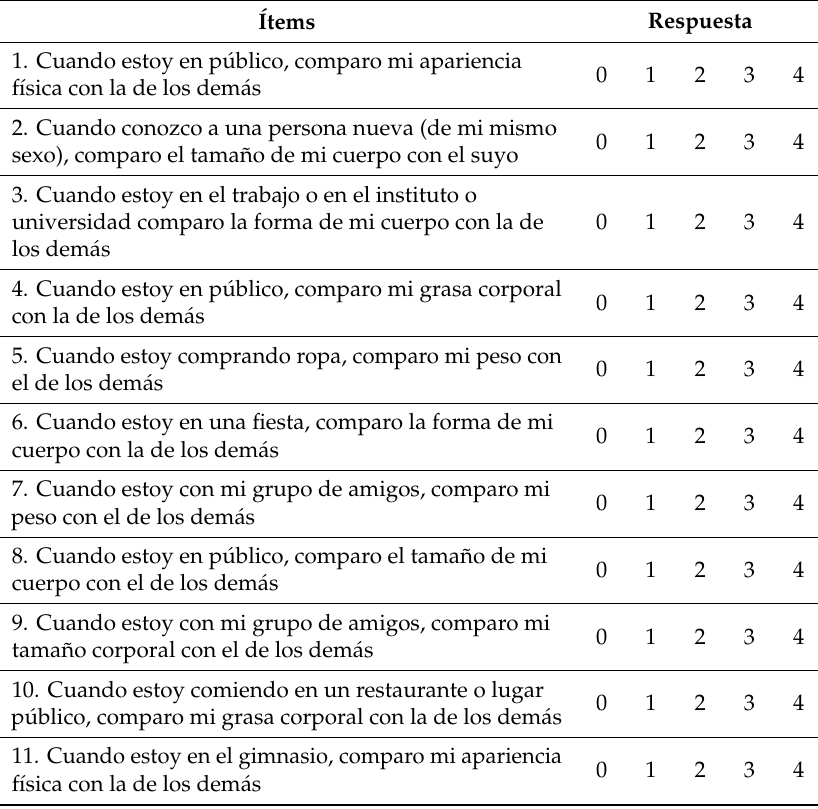
Table A1. Spanish translation of the Physical Appearance Comparison Scale-Revised (PACS-R). Í